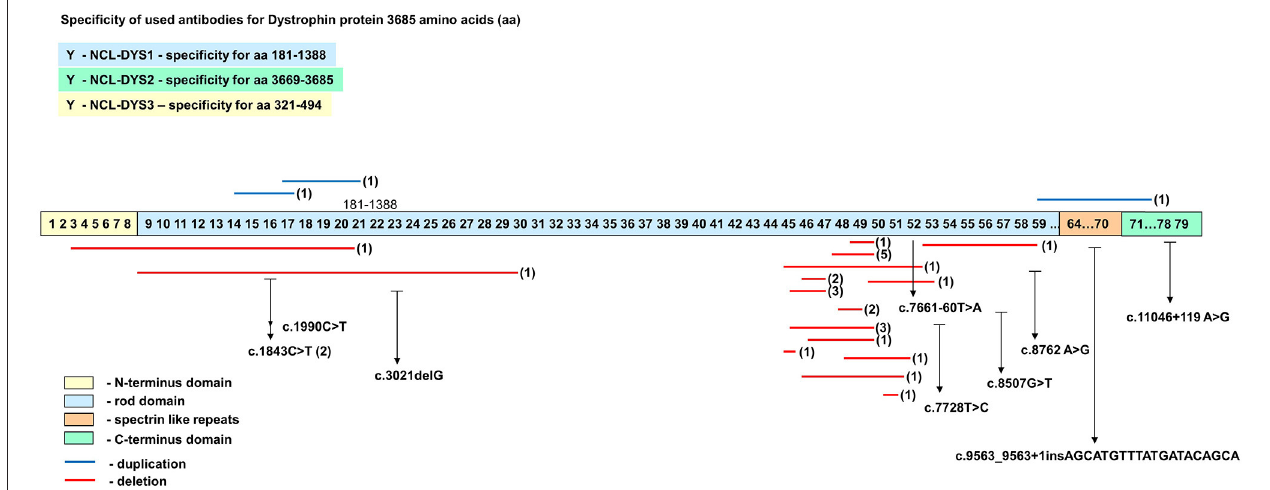
FIGURE 5 | Schematic representation of the distribution pattern of mutations along the DMD gene.